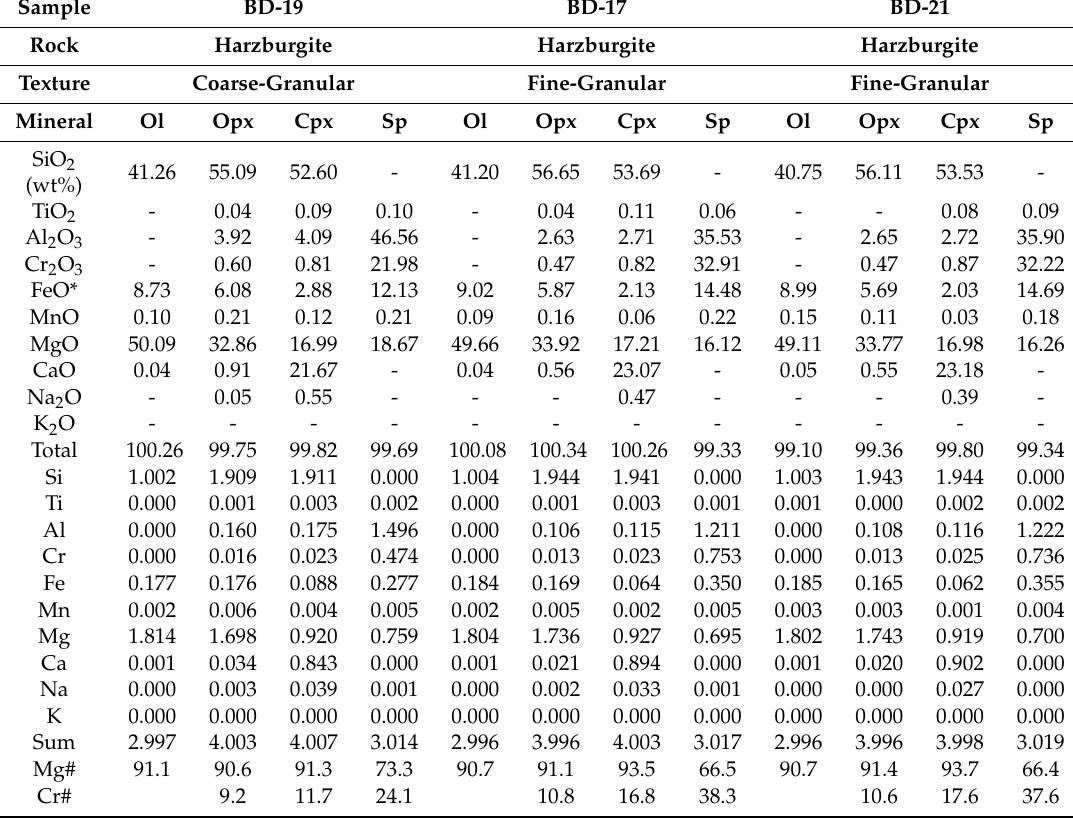
Table 2. Compositions of minerals of studied peridotite xenoliths from